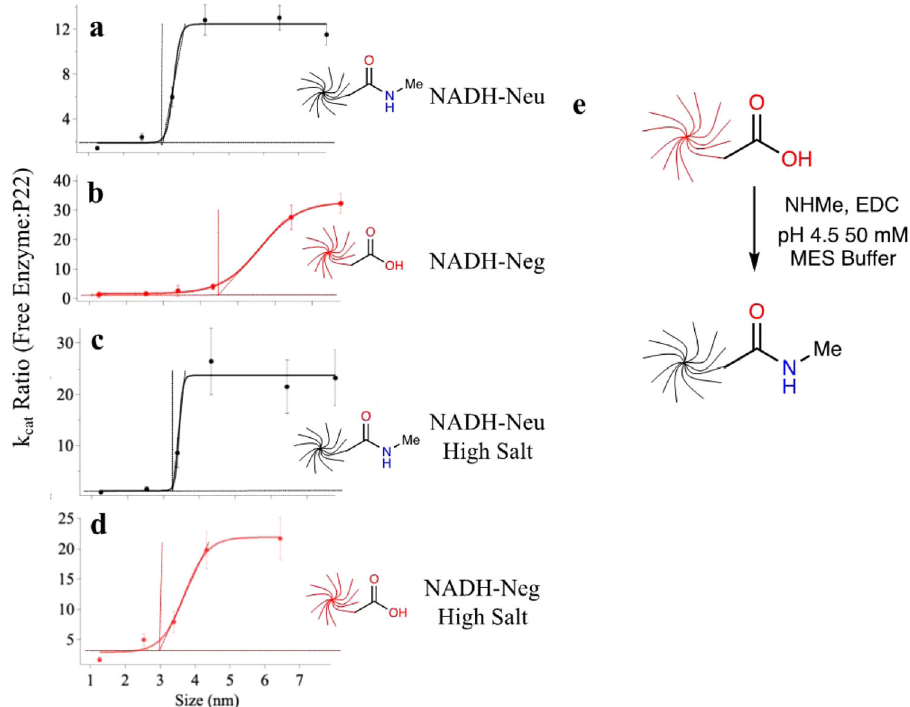
Fig. 5 Effects of electrostatics on the effective pore size of P22 PC VLPs. All graphs ( a – d ) are portrayed as the ratio of extracted k cat values for free AhdD-SP enzymes and those encapsulated inside P22 particles versus diameter of NADH conjugates with sigmoidal fi ts. The data acquired using NADH- Neu are depicted in black, while with NADH-Neg in red. a Effective pore size of 3 nm using neutral dendrimers in pH 7, 50 mM sodium phosphate, 100 mM sodium chloride. b Effective pore size of 4.3 nm using negative dendrimers in pH 7, 50 mM sodium phosphate, 100 mM sodium chloride. c Effective pore size of 3.2 nm using neutral dendrimers in pH 7, 50 mM sodium phosphate, 400mM sodium chloride. d Effective pore size of 3.0 nm using negative dendrimers in pH 7, 50 mM sodium phosphate, 400 mM sodium chloride. The limits of the y- axis in a – d are not uniform in order to more accurately compare the activity differences between the P22-AdhD and the free enzyme with respect to the size of the NADH conjugates. e Scheme of reaction used in order to neutralize the negative charges on the dendrimers. Error bars = standard deviation ( n =